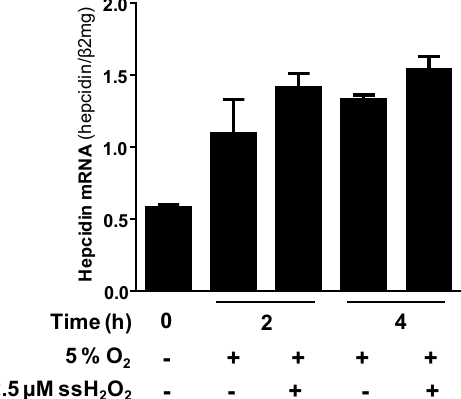
Figure 5. Hypoxia induces hepcidin alone or after co-exposure to low steady state (ss) levels of H 2 O 2 . Notably, hypoxia further enhances the H 2 O 2 -mediated upregulation of hepcidin via STAT3 [58]. Preliminary data indicate that hypoxia-associated hepcidin upregulation is also STAT3-mediated, pointing towards an oxidase as important upstream regulator of hepcidin. Hepcidin mRNA was quantified by quantitative real-time PCR and the results are represented as mean of hepcidin mRNA normalized to β 2-microglobulin ( β 2mg) ± standard deviation.